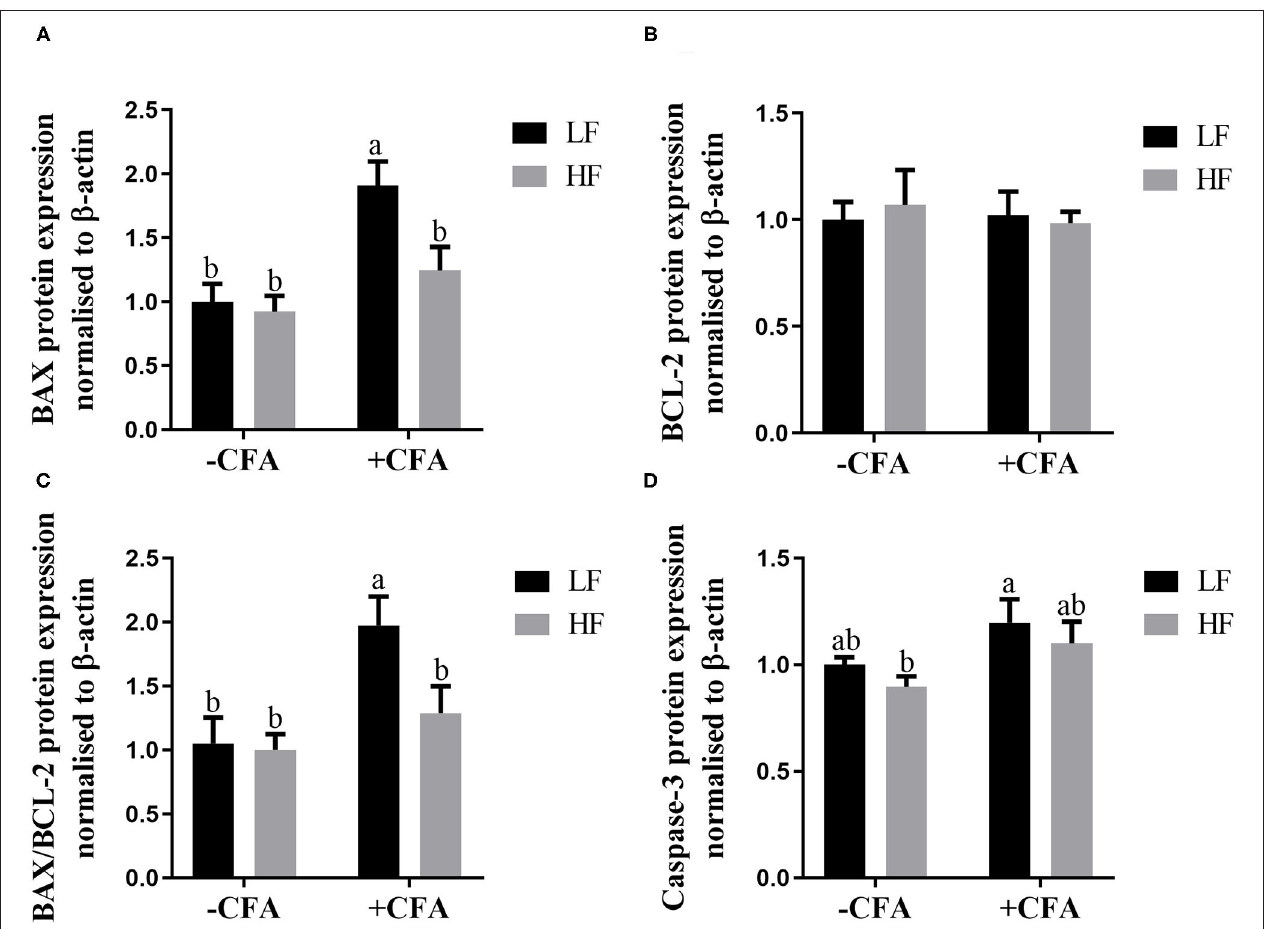
FIGURE 11 | Relative protein expression of BAX (A) , BCL-2 (B) , BAX/BCL-2 (C) , and Caspase-3 (D) in lung of piglets fed diets supplemented fiber following CFA challenge. a,b Mean value with unlike letters were significantly different ( p <